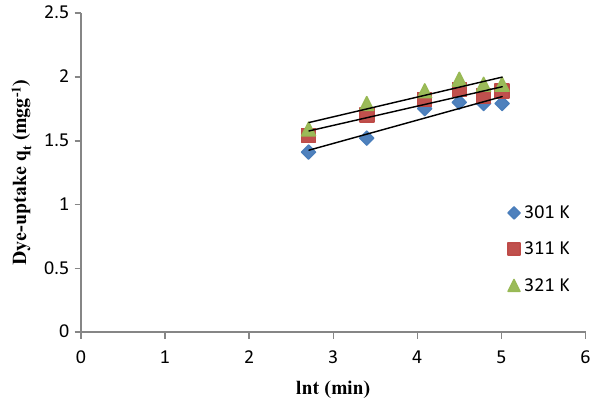
Fig. 9 Elovich kinetic plots for adsorption of CR dye on MSC at dif- ferent temperatures